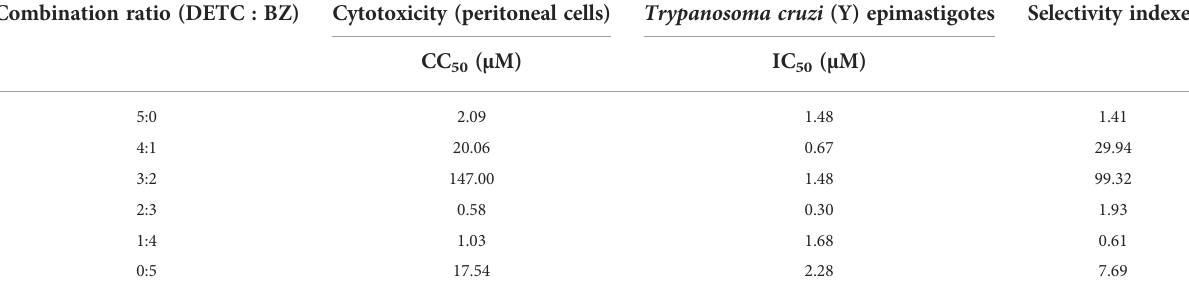
TABLE 1 Trypanocidal activity, cytotoxicity, and selectivity indexes of the DETC + BZ combination after 24 h of treatment. Combination ratio (DETC : BZ) Cytotoxicity (peritoneal cells)